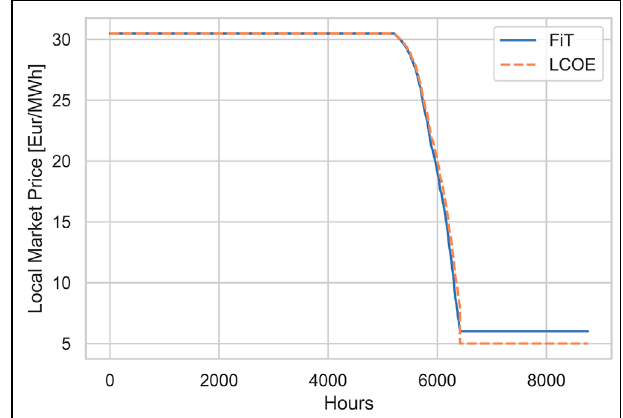
FIGURE 5 | Duration curves of the local energy market prices for the scenarios with fixed utility